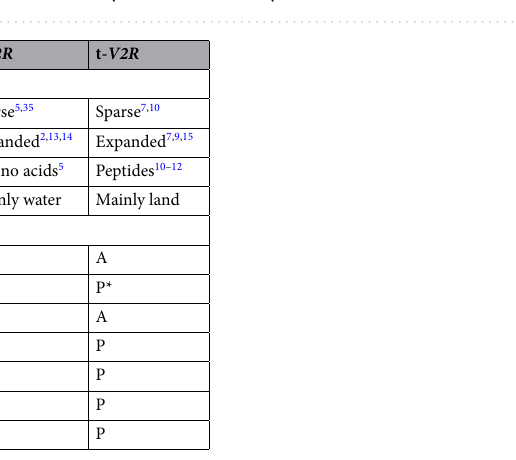
Figure 3. The expression patterns of V2R s in the olfactory epithelium of the basal ray-finned fish, Polypterus senegalus . Overall view of a HE-stained horizontal section of the olfactory organ, showing that lamellae of olfactory organ are stained blue-violet, and the nerve bundles are stained red-violet ( A ). Expression of four V2R genes were confirmed by FISH on horizontal sections of the olfactory organ of the bichir using DIG-labeled RNA antisense probes for f- V2R ( B ) and t- V2R ( C ), V2R2 ( D ), and ancV2R ( E ). Green indicated the expression signals. The blue area indicates the cell nucleus stained with DAPI. V2R2 was globally expressed in the deep layers of olfactory lamellae ( D ). In contrast, f- V2R , t- V2R , and ancV2R were sparsely expressed in a small number of neurons in the deeper layers of the olfactory lamellae ( B , C , and E ). ( B ’- E ’) High magnification view of the dotted squares in B – E . Scale bars show 1 mm ( A ), 100 µm ( B – E ) and 20 µm ( B ’– E ’).